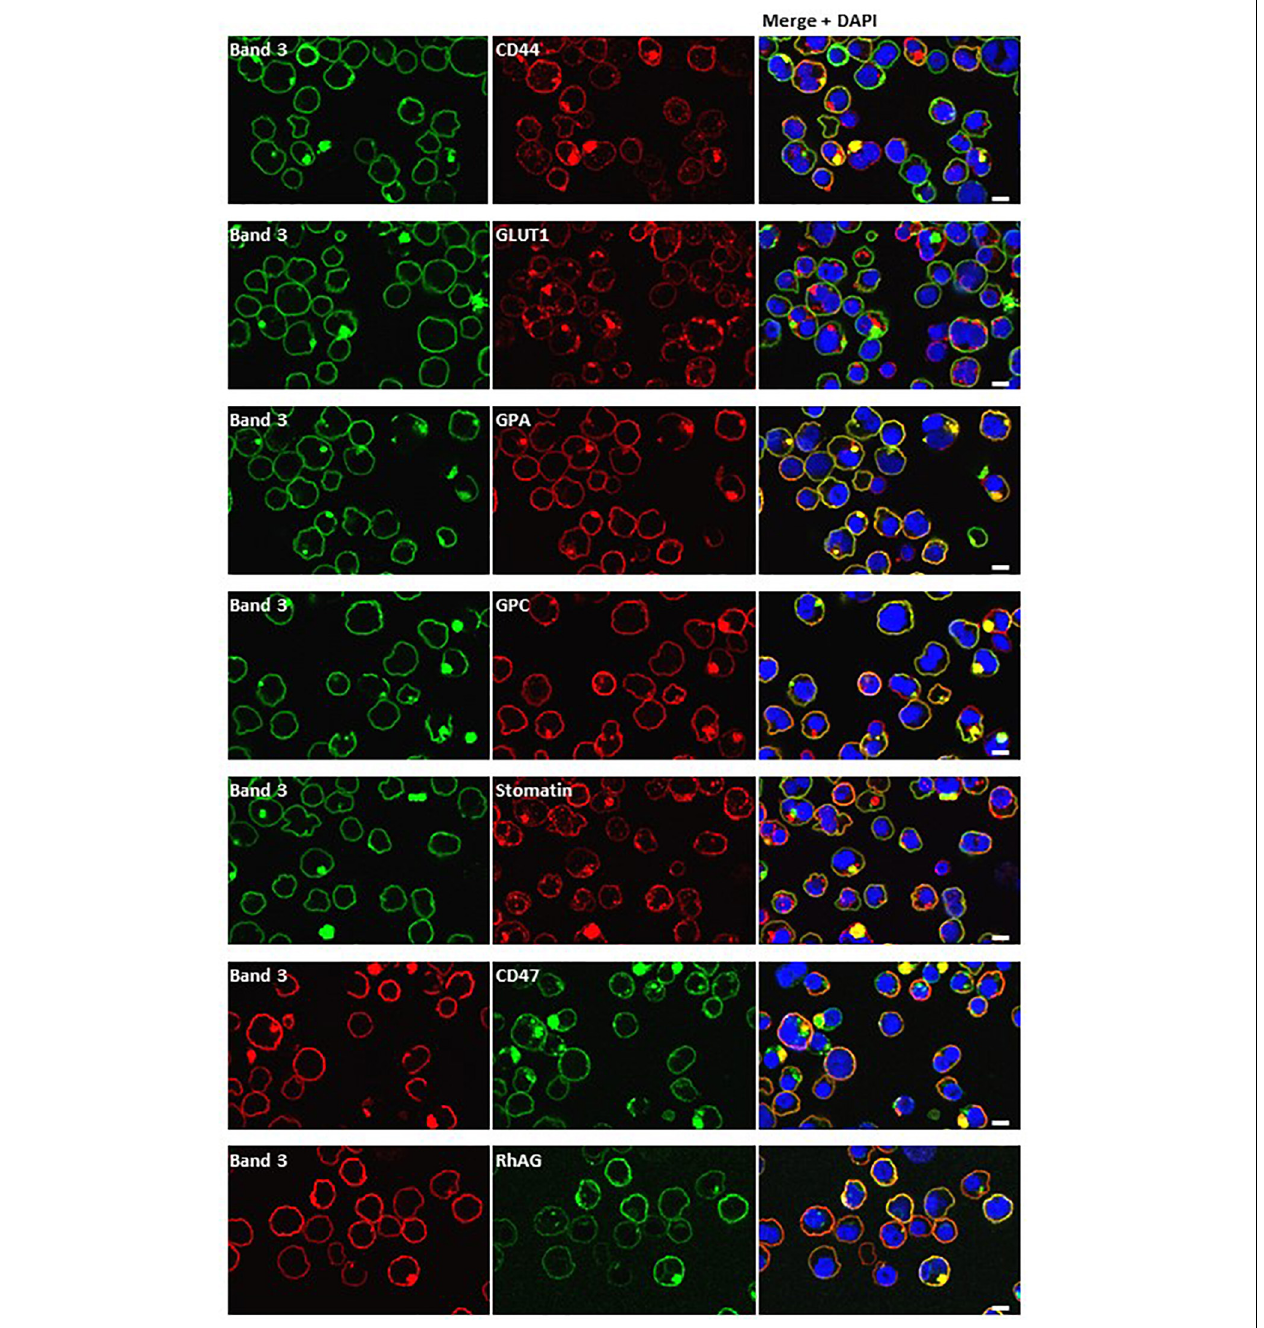
FIGURE 8 | Dual staining with plasma membrane markers. Late stage homozygous SAO cells were fixed, permeabilized and dual stained with anti-band 3 (BRIC170, green; or BRAC17, red) and antibodies against plasma membrane proteins. Antibodies used were rabbit polyclonals against CD44, GLUT1 (gift from Prof. S. Baldwin), GPA, GPC and mouse monoclonals against stomatin (gift from Prof. R. Prohaska; GARP50), CD47 (BRIC211) and RhAG (LA1818). Yellow areas in merged images indicate colocalization. Scale bars represent 5 µ m.